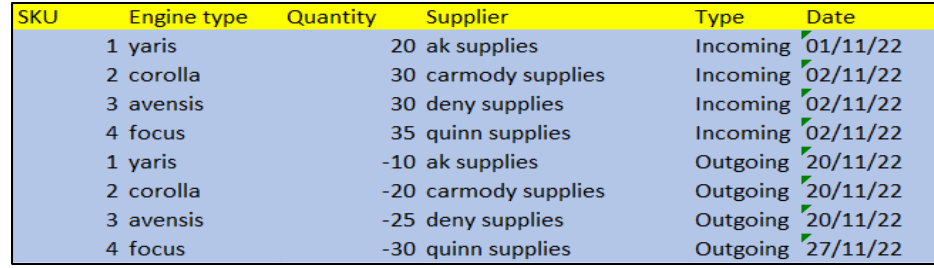
Fig 8a. Copied data from the incoming/outgoing app screen.